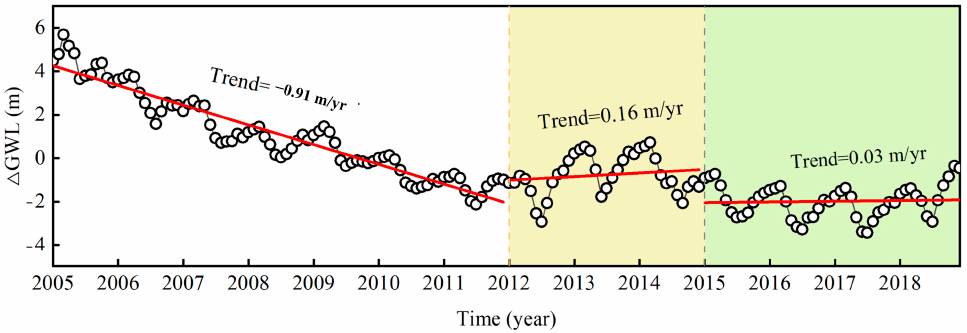
Figure 4. Average △ GWL in the Beijing Plain from 2005 to 2018 and GWL trends in different periods.